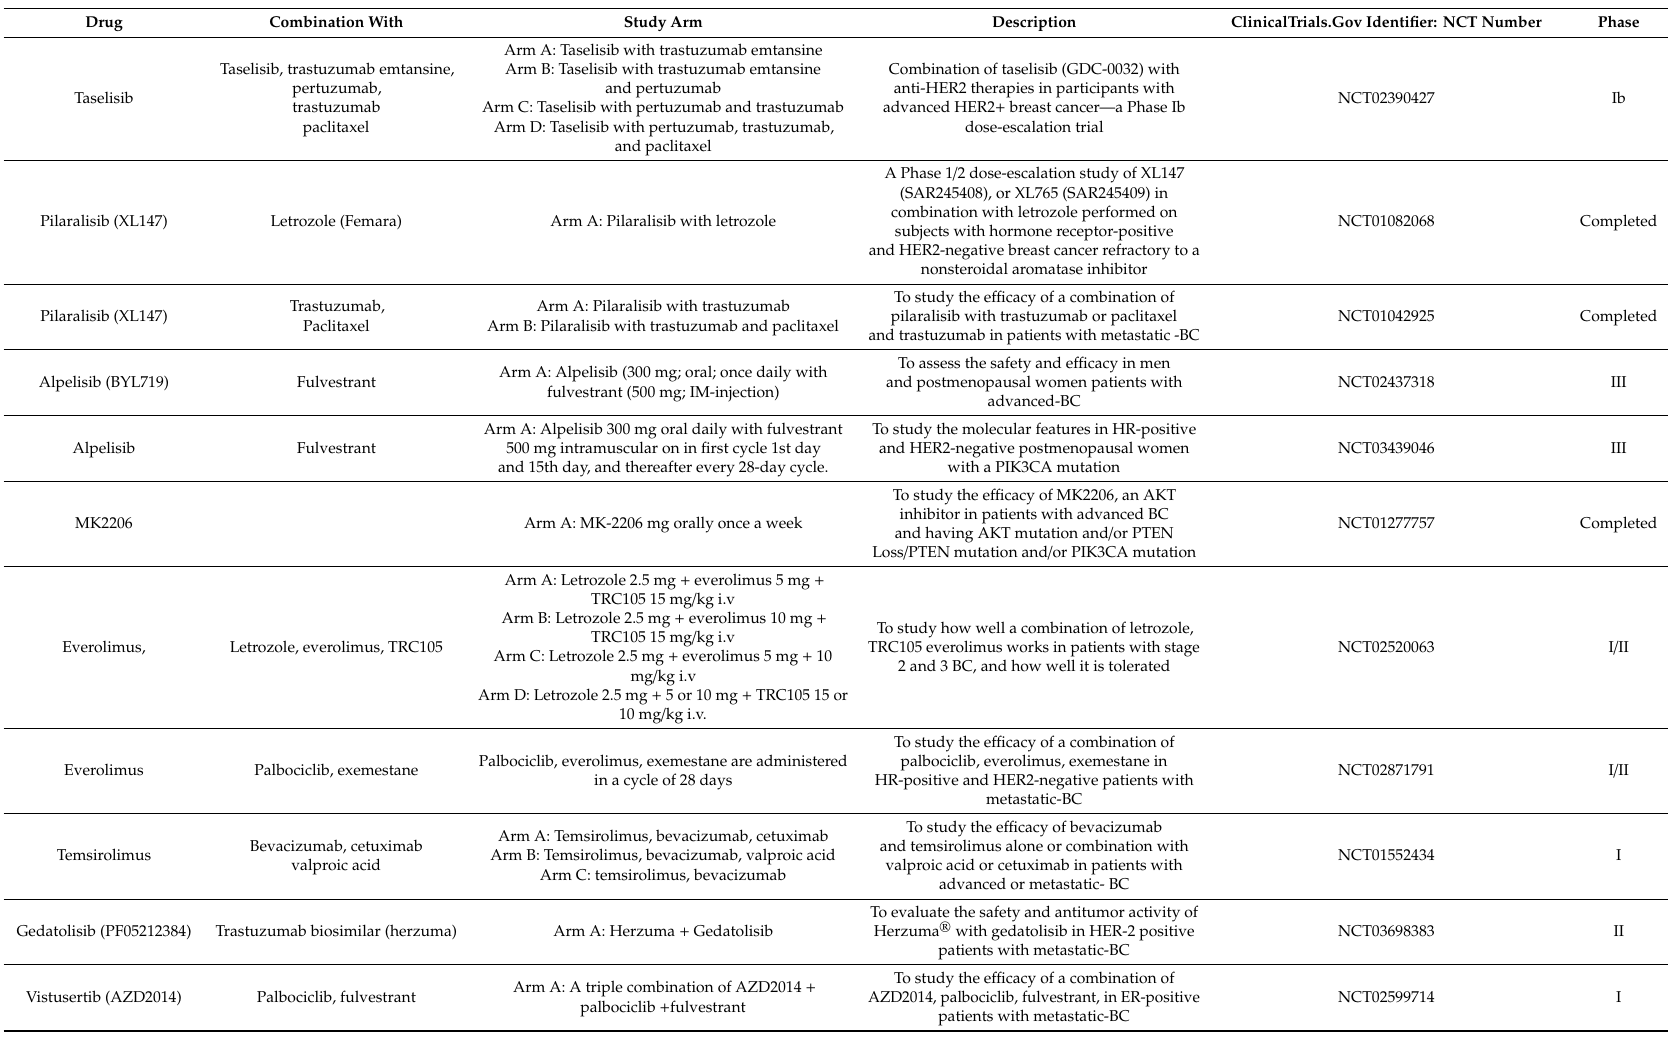
Table 4. List of drugs / combinations of PI3K / AKT / mTOR inhibitors and other agents under clinical